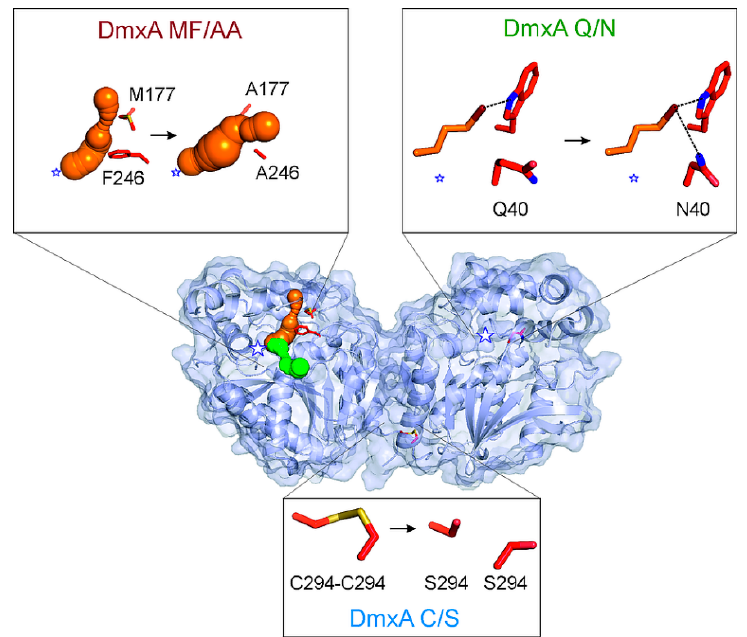
Figure 4. The overall structure of DmxA dimer represented by a diagram showing the solvent accessible surface. The main tunnel connecting the surface and the surrounding solvent with the hydrophobic pocket containing the catalytic pentad is shown in orange and residues forming the tunnel bottleneck are highlighted in sticks. The slot tunnel accessing the active site of DmxA wt is depicted as green sphere. DmxA wt is the only dehalogenase forming a dimer containing disulfide bridge between C294 residues. Mutant DmxA C / S was constructed by replacing C294 with serine to examine the e ff ect of cysteine bridge on stability and dimerization of DmxA. The non-contributing residue Q40 is replaced by N40 to provide two halide-coordinating residues in the reactive center of DmxA Q / N variant. Position of side-chain of N40 in the variant DmxA Q / N enables stronger binding of the halide released during the S N 2 reaction. Structural analysis of DmxA reveals quite narrow tunnels, while the most important bottleneck in the main tunnel is formed by the residues M177 and F246. These residues were replaced by alanine in the variant DmxA MF / AA, resulting in a widely opened main tunnel. The white stars represent positions of the active sites in the enzyme structure, with respect to the tunnels and / or catalytic